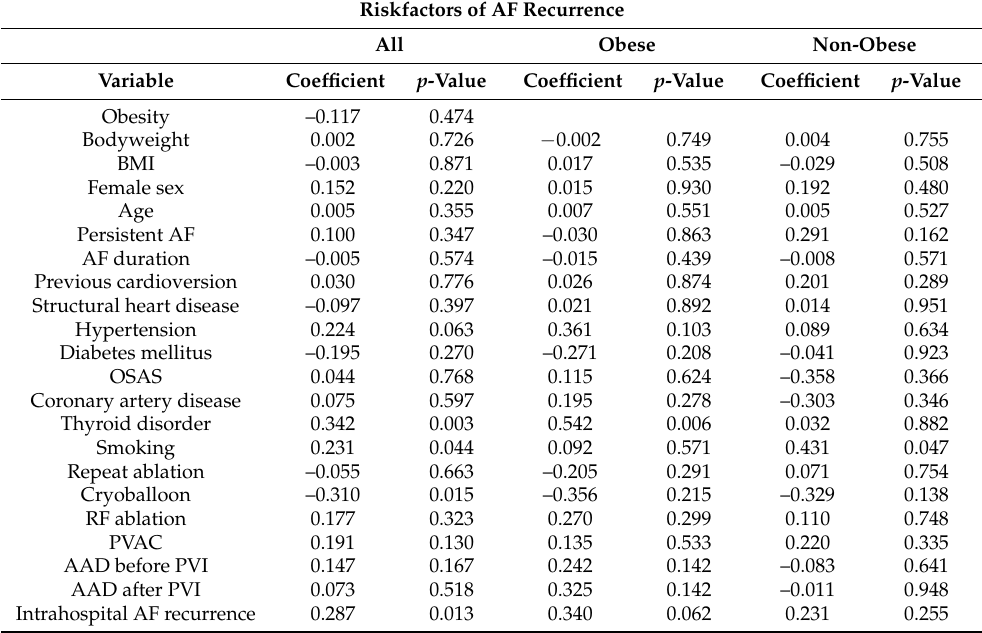
Table 5. Univariate analysis for risk factors of AF recurrence following PVI in obese and non- obese